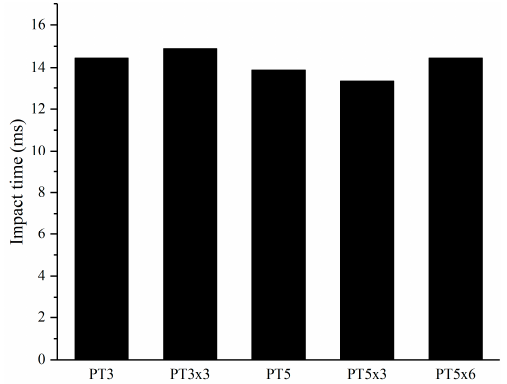
Figure 6. The impact time for a 10 µ L droplet for all coatings. Free-fall height is set to 300 mm.